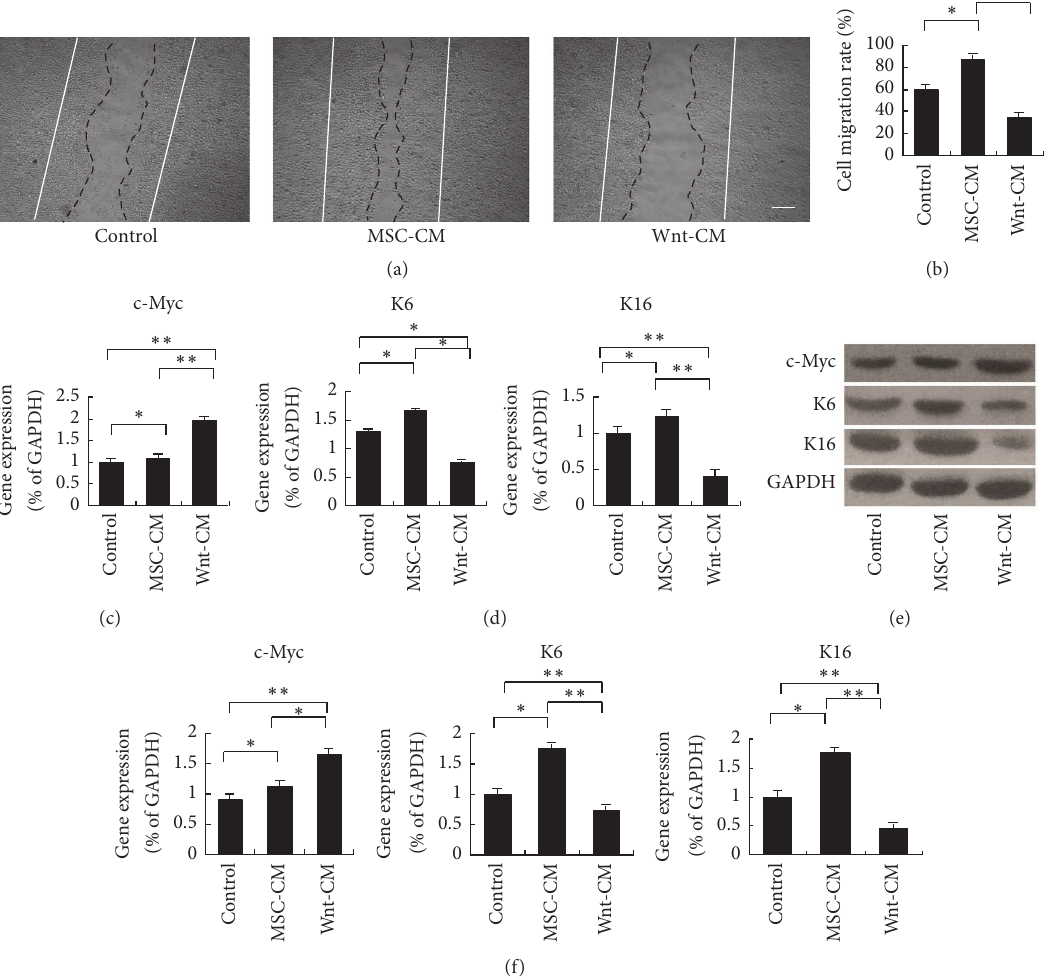
Figure 6: Wnt-CM inhibits migration and expression of the cytoskeletal components K6 and K16 via upregulation of c-Myc in human keratinocytes. (a and b) Wnt-CM inhibited migration of human keratinocytes in the wound scratch assay after 24 h as compared to MSC-CM and DMEM. (c) Expression levels of c-Myc mRNA after treatment with Wnt-CM, MSC-CM, or DMEM were analyzed by real-time PCR and normalized to that of GAPDH. (d) Expression levels of K6 and K16 mRNA after treatment with Wnt-CM, MSC-CM, and DMEM were analyzed by RT-PCR and normalized to that of GAPDH. (e, f) Western blots analysis of c-Myc, K6, K16, and corresponding semiquantitative analysis. The data represent mean ± SEM, 𝑛 = 3 ; ∗ 𝑃 < 0.05 and ∗∗ 𝑃 < 0.01 . Solid lines indicate the initial wound area; dotted lines demarcate the migrating front of the cells. The scale bar in panel (a) is 100 𝜇